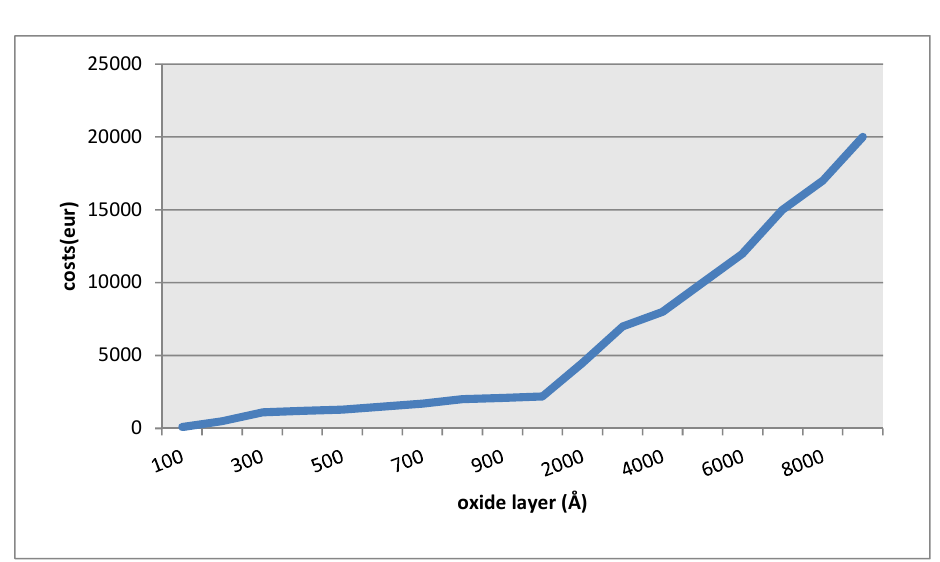
Figure 2 – The costs of environment (Source: own processing)